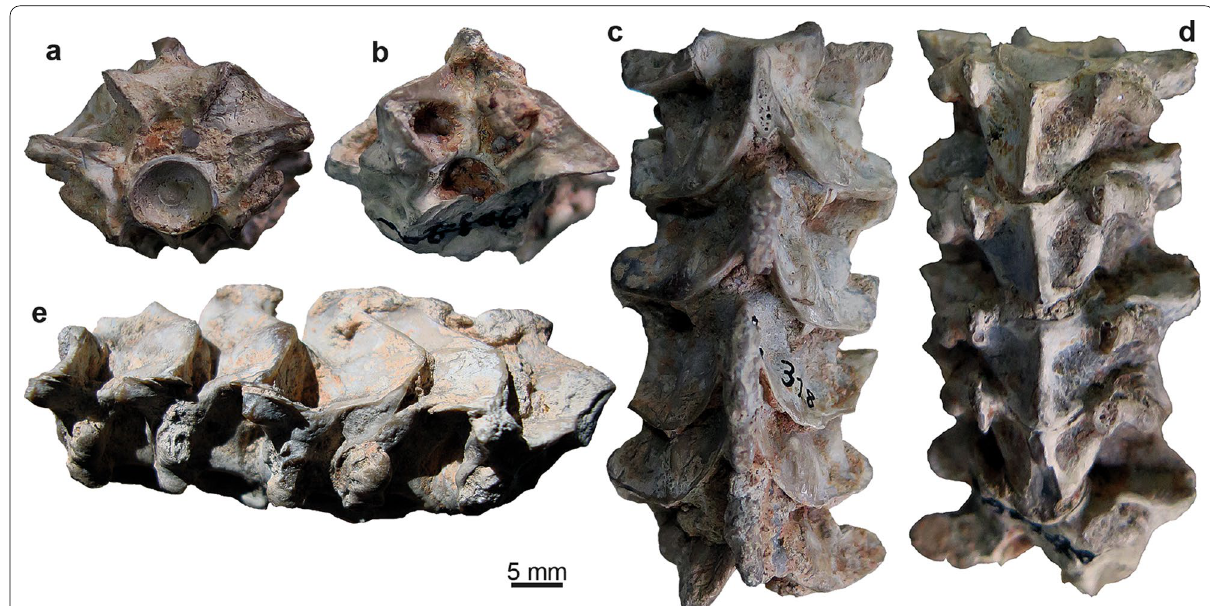
Fig. 4 Palaeopython cadurcensis from an imprecisely known locality in the Phosphorites du Quercy, lectotype (herein designated): five articulated mid-trunk vertebrae (MNHN.F QU16318), in anterior ( a ), posterior ( b ), dorsal ( c ), ventral ( d ), and left lateral ( e ) views